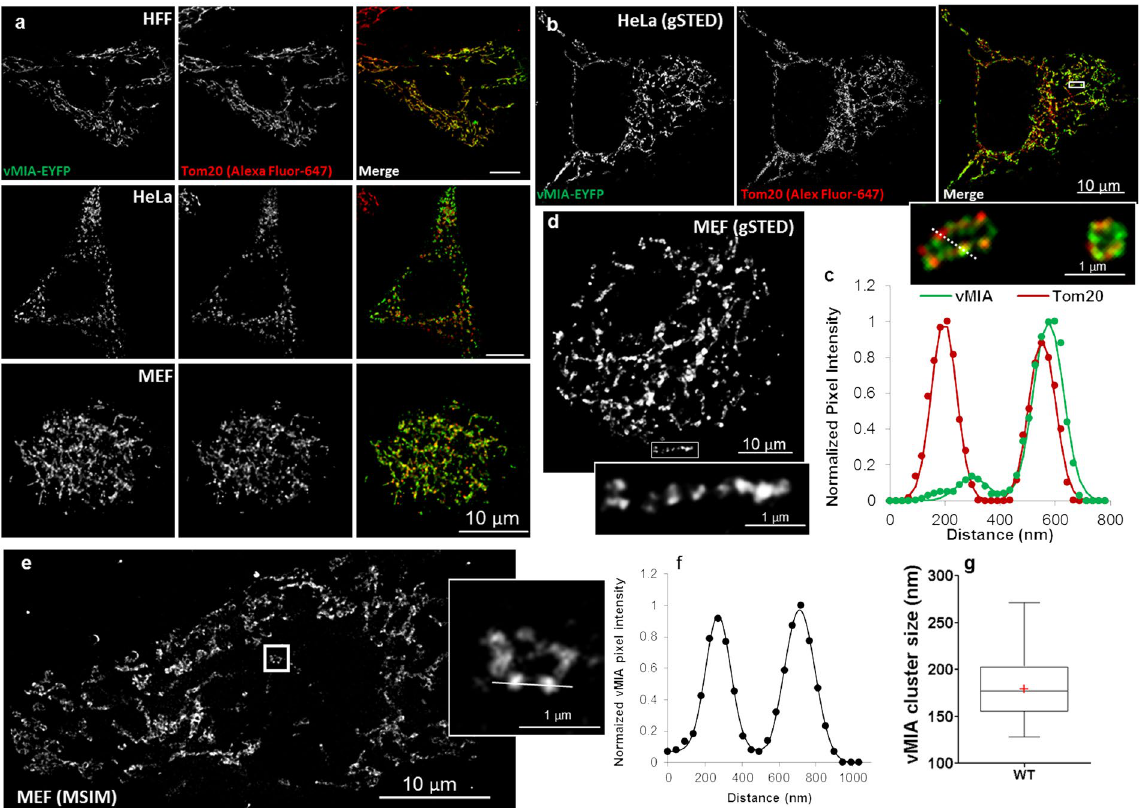
Figure 1. vMIA traffics to and clusters at the OMM in mouse embryonic fibroblasts. ( a ) Human (HFF and HeLa) and mouse (MEF) fibroblasts were transfected transiently (19 hours) to express vMIA-EYFP and then immunolabeled for the OMM marker Tom20. The images show an optical slice obtained by deconvolution of a confocal z-stack. ( b ) A single optical plane from deconvolved z-stack of gSTED images showing clustered distribution of vMIA-EYFP and Tom20 (immunostained) on the OMM of a HeLa cell transfected as above. Zoom shows the merged image marked by white box in the merged channel. ( c ) Normalized intensity profile of the red and green pixels marked by the dotted line in the zoomed region in panel b. ( d ) Single optical plane from deconvolved z-stack of gSTED images showing clustered distribution of vMIA-EYFP on the OMM in a WT MEF. Zoom shows the region marked by white box. ( e ) A single plane from an MSIM z-stack images showing clustered distribution of vMIA-EGFP on the OMM of a transfected MEF cell. Zoom of a single mitochondrion (boxed) shows vMIA clustering and line marks the region used to plot the intensity profile in the panel d. ( f ) Normalized intensity profile of the mitochondrion along the pixels marked by the solid line in the zoomed region. ( g ) Plot showing vMIA cluster size (FWHM) in WT MEFs. The line in the box and red, cross mark indicate the median (177.0) and mean (179.9 ± 3.7), respectively (n =